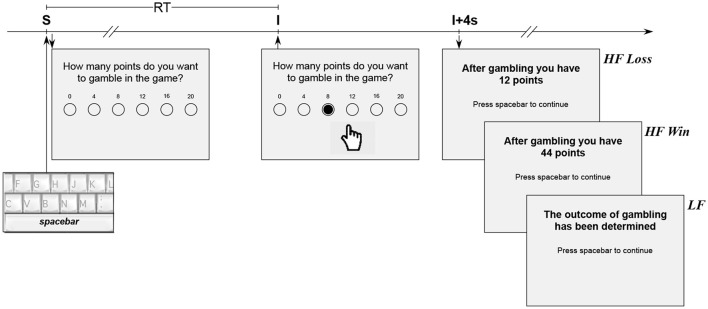
Experimental design of the probabilistic gambling task. Each trial began by pressing the spacebar (trigger event S), which was immediately followed by a message on the computer-controlled monitor with the request to choose a selected amount of points to gamble in a game. The response time (RT) was determined by the lag until the selection of the investment to gamble (trigger event I). After an additional fixed interval of 4 s (I+4s), the participant was informed about the outcome of the gamble (HF Loss or HF Win) in the HF condition or simply informed about the determination of the gamble in the LF condition.